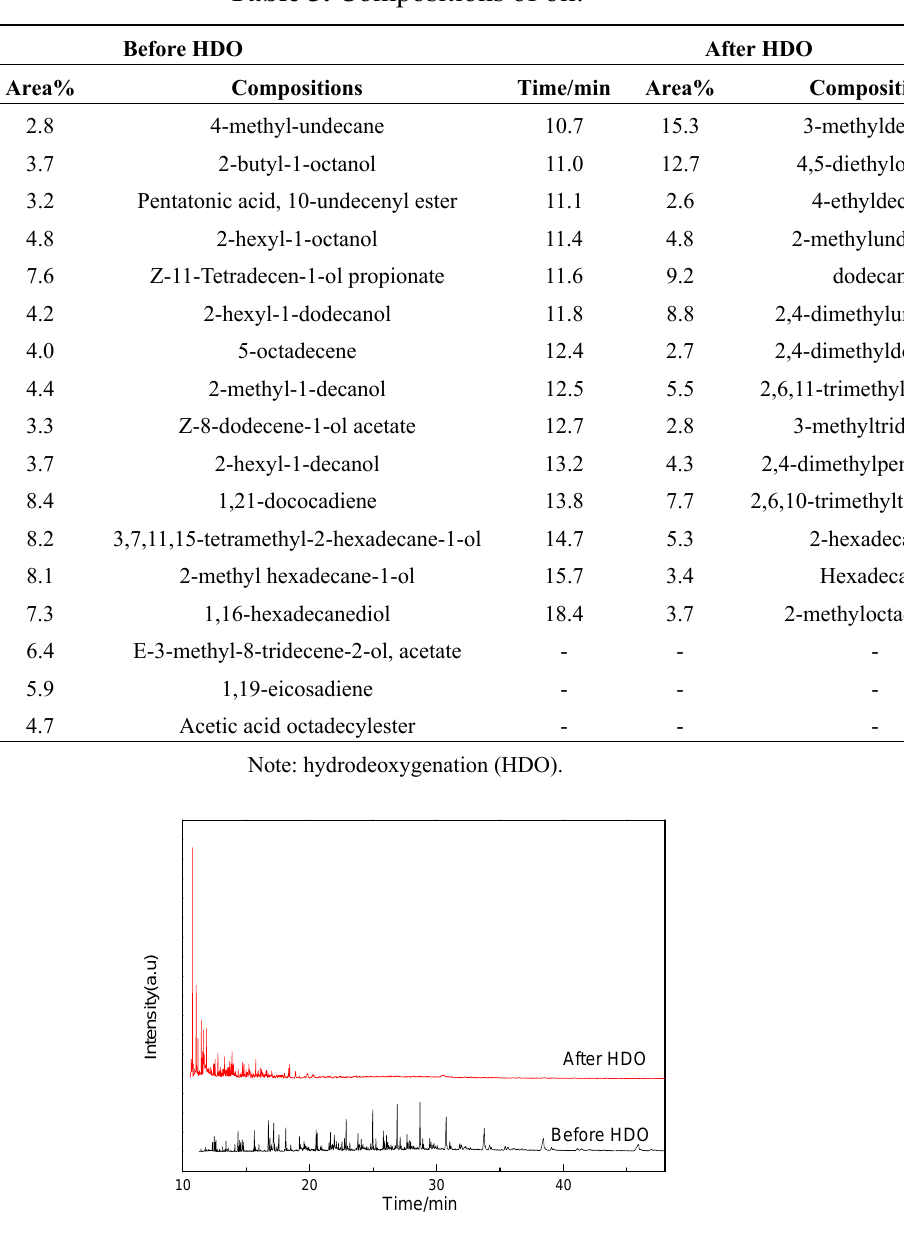
Figure 7. GC-MS chromatogram of crude